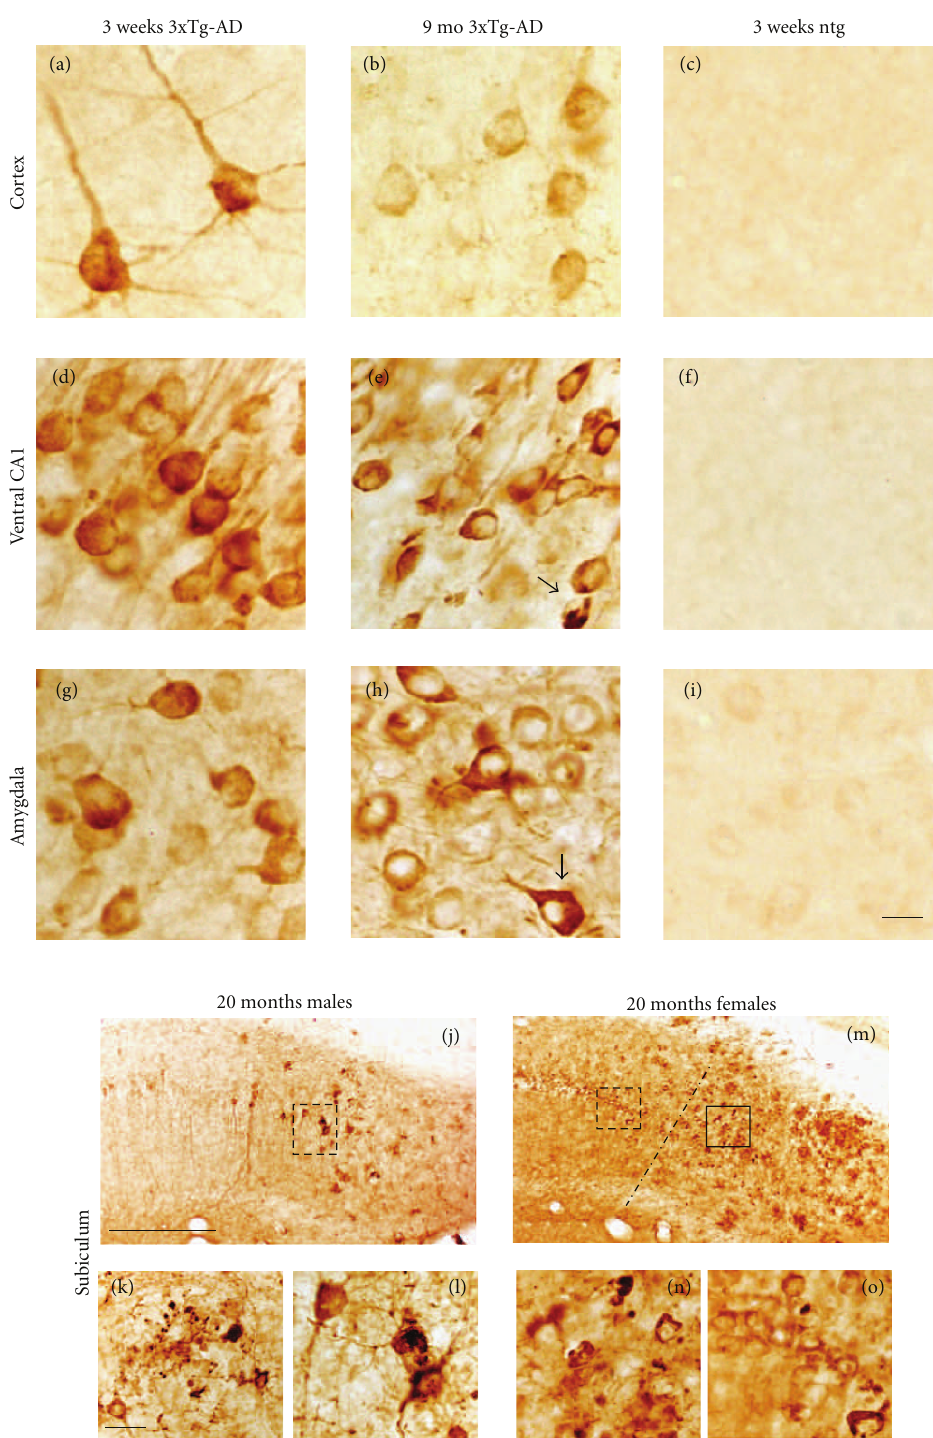
Figure 9: Photomicrographs showing AT180 immunoreactivity in the cortex ((a)–(c)), ventral CA1 ((d)–(F)), BLA ((g)–(i)), and subiculum ((j)–(o)) in 3xTg-AD mice. Note the more intense AT180-ir perinuclear staining (arrows), particularly in the BLA (h), and the shrunken appearance of ventral hippocampal neurons (e) at 9 months of age when compared to 3 weeks of age ((d), (g)). Greater AT180-ir tau pathology was observed in females than that in males at the CA1/subicular interface ((j), (m)). Higher magnification of dashed boxes in (j) and (m) are represented in (l) and (o), respectively, while (n) represents higher magnification of solid box in (m). Ntg mice showed only light background staining ((c), (f), (i)). Scale bars: ((a)–(i)); ((k), (l), (n), (o)) = 20 μ m and (j, m) = 100 μ